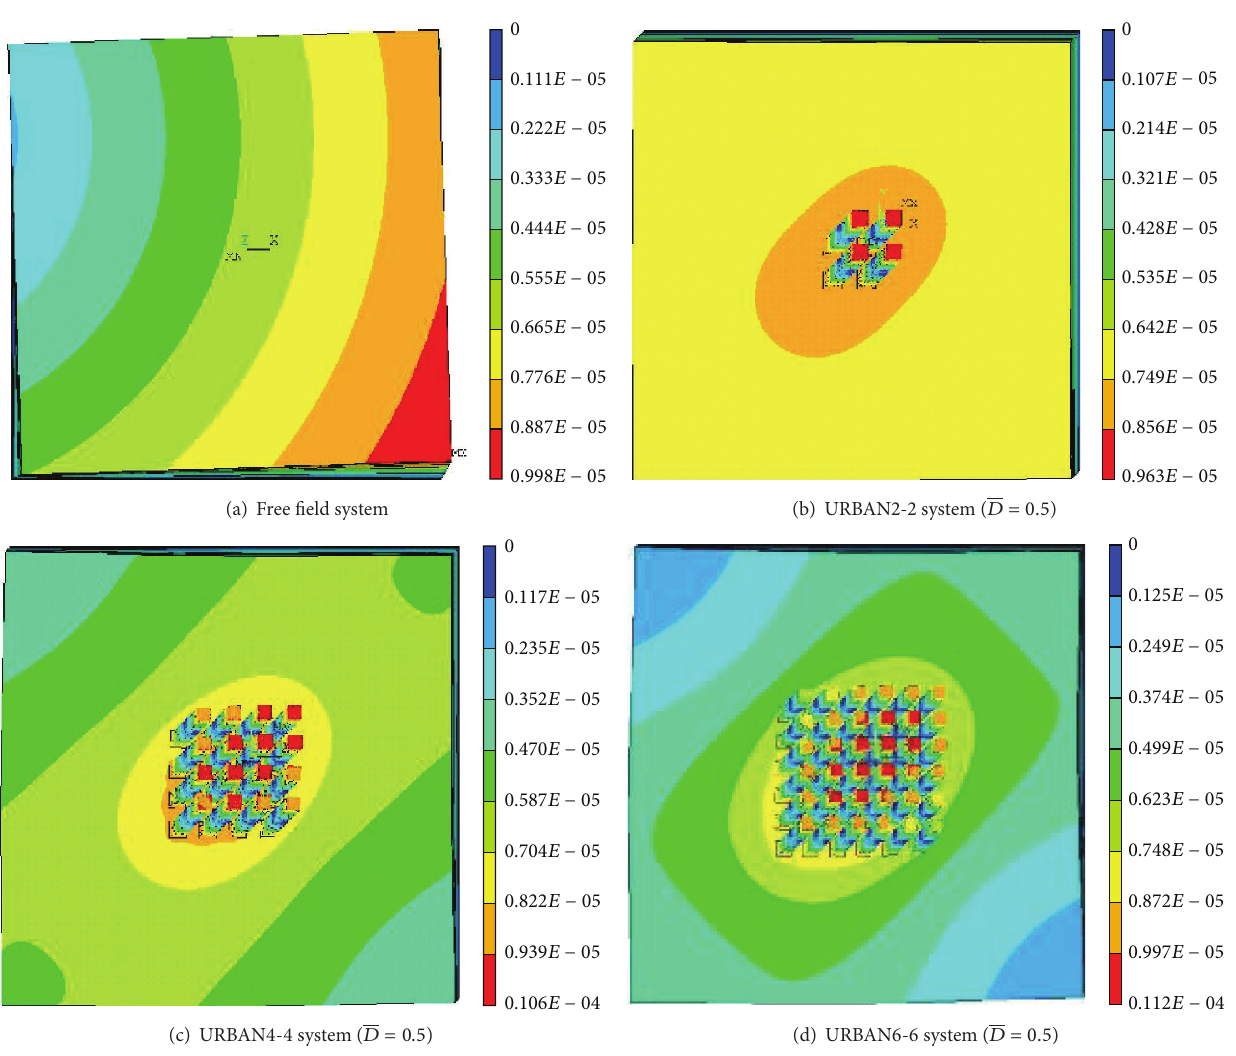
Figure 5: System First mode